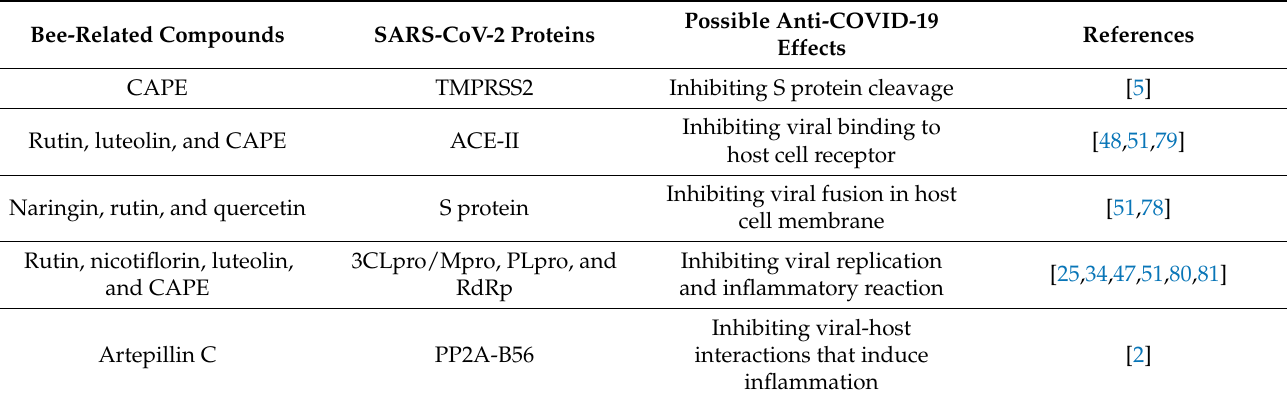
Table 1. Flavonoids from propolis and bee honey exhibiting the highest binding to severe acute respiratory syndrome- coronavirus-2 (SARS-CoV-2) proteins and host cell receptor/proteases in silico along with their possible anti-Coronavirus Disease 2019 (COVID-19) effects.